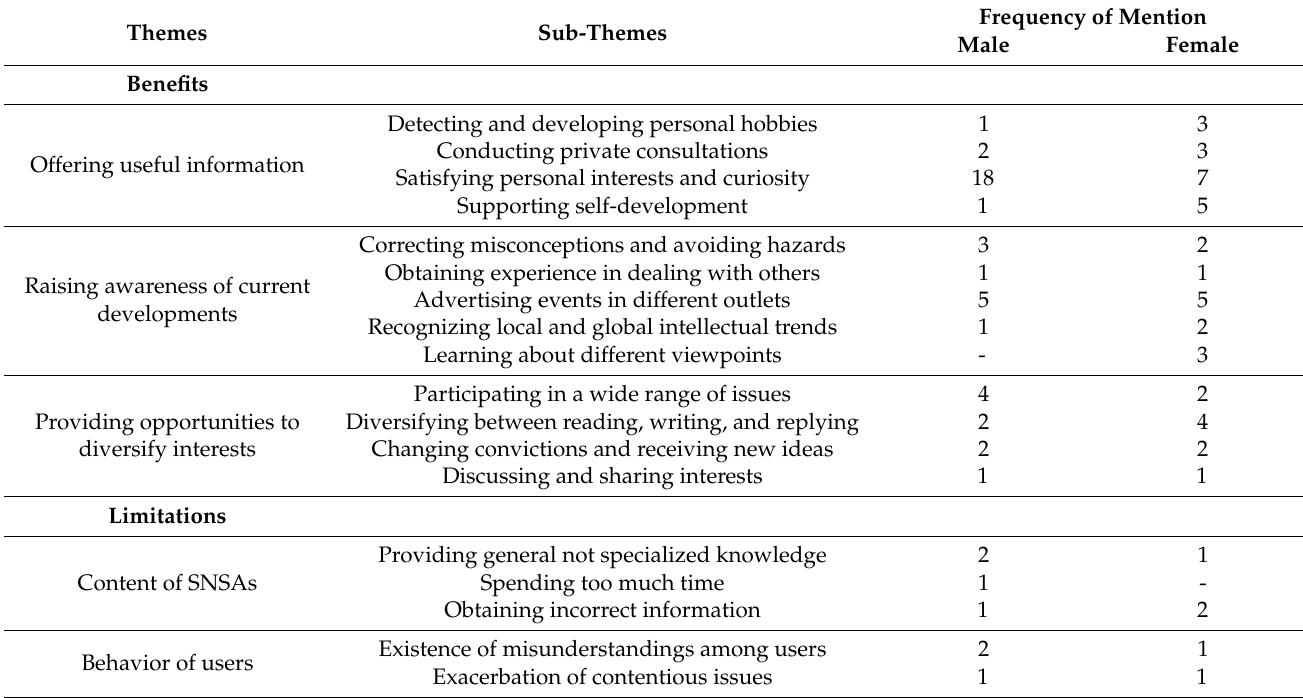
Table 8. Themes relating to SNSAs and life satisfaction.